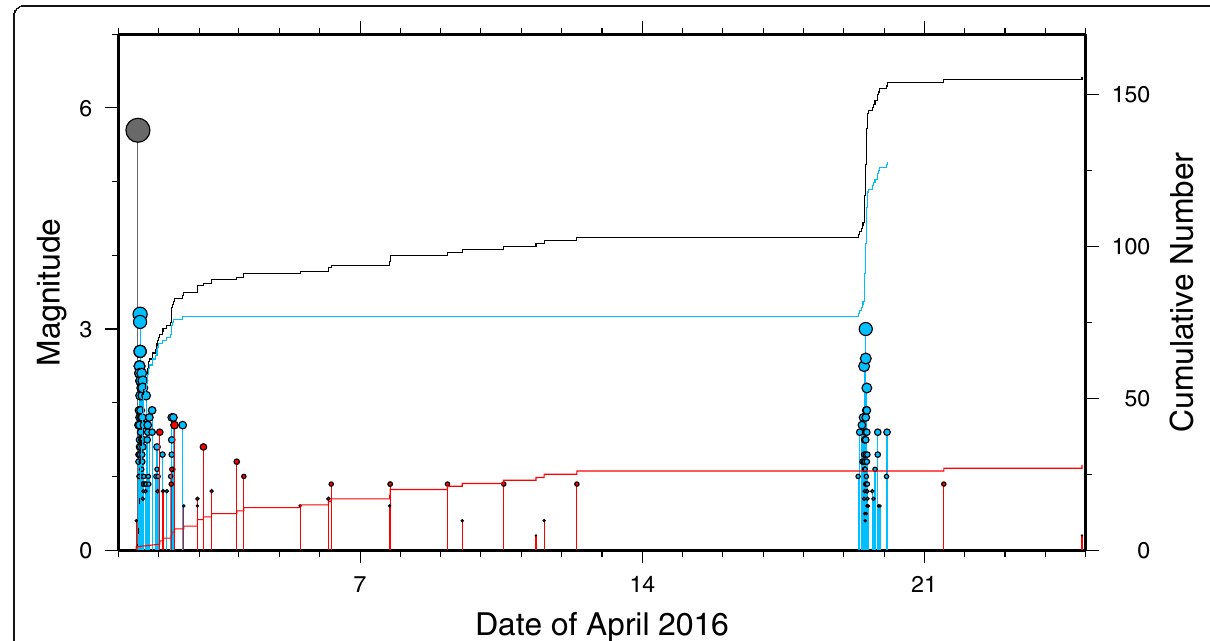
Fig. 4 Cumulative number and magnitude of mainshock and aftershocks plotted against time. Circles with vertical bars represent the magnitude of the earthquake. The black line represents the cumulative number of aftershocks. Blue and red lines correspond to those occurring in the northeastern and southwestern clusters separated by a dashed line, shown in Fig.